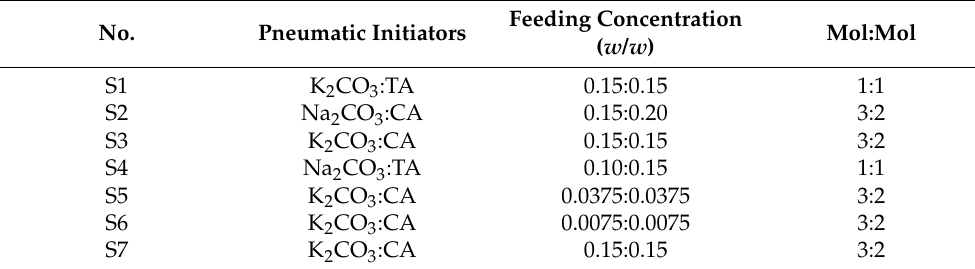
Table 4. Optimization of pneumatic